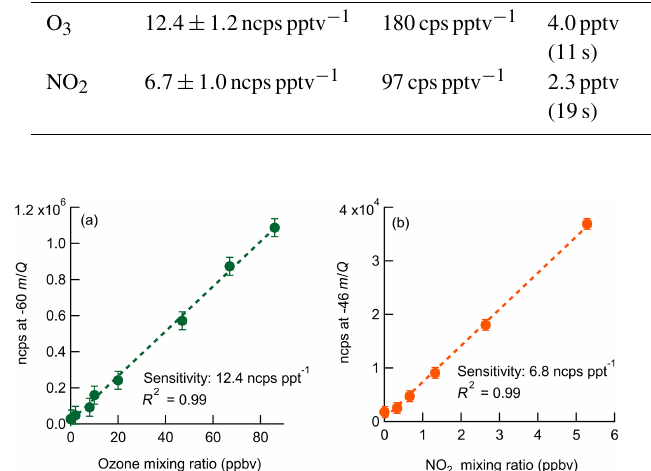
Figure 2. Normalized calibration curves of O 3 (a) and NO 2 (b) at 8gkg − 1 specific humidity (approximately 40% RH at 25 ◦ C). Ozone is detected as CO − at − 60 m/Q . NO 2 is detected as the 3 charge transfer product (NO − ) at − 46 m/Q . Error bars are the stan- 2 dard deviation in normalized count rate for each measurement